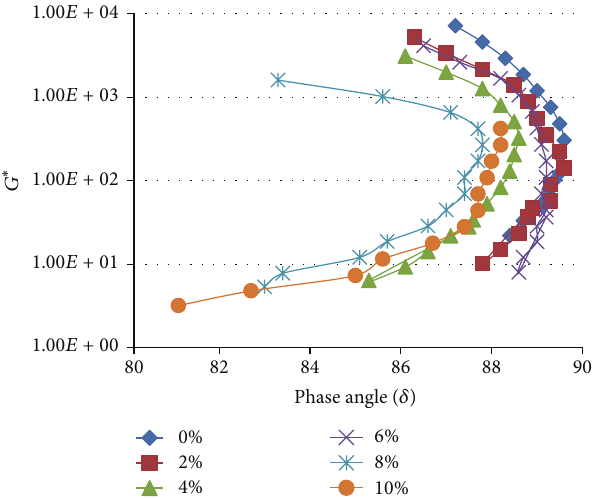
Figure 10: Black curves for WCO modified TPB blends measured at 1.59 Hz and 60 ∘ C.